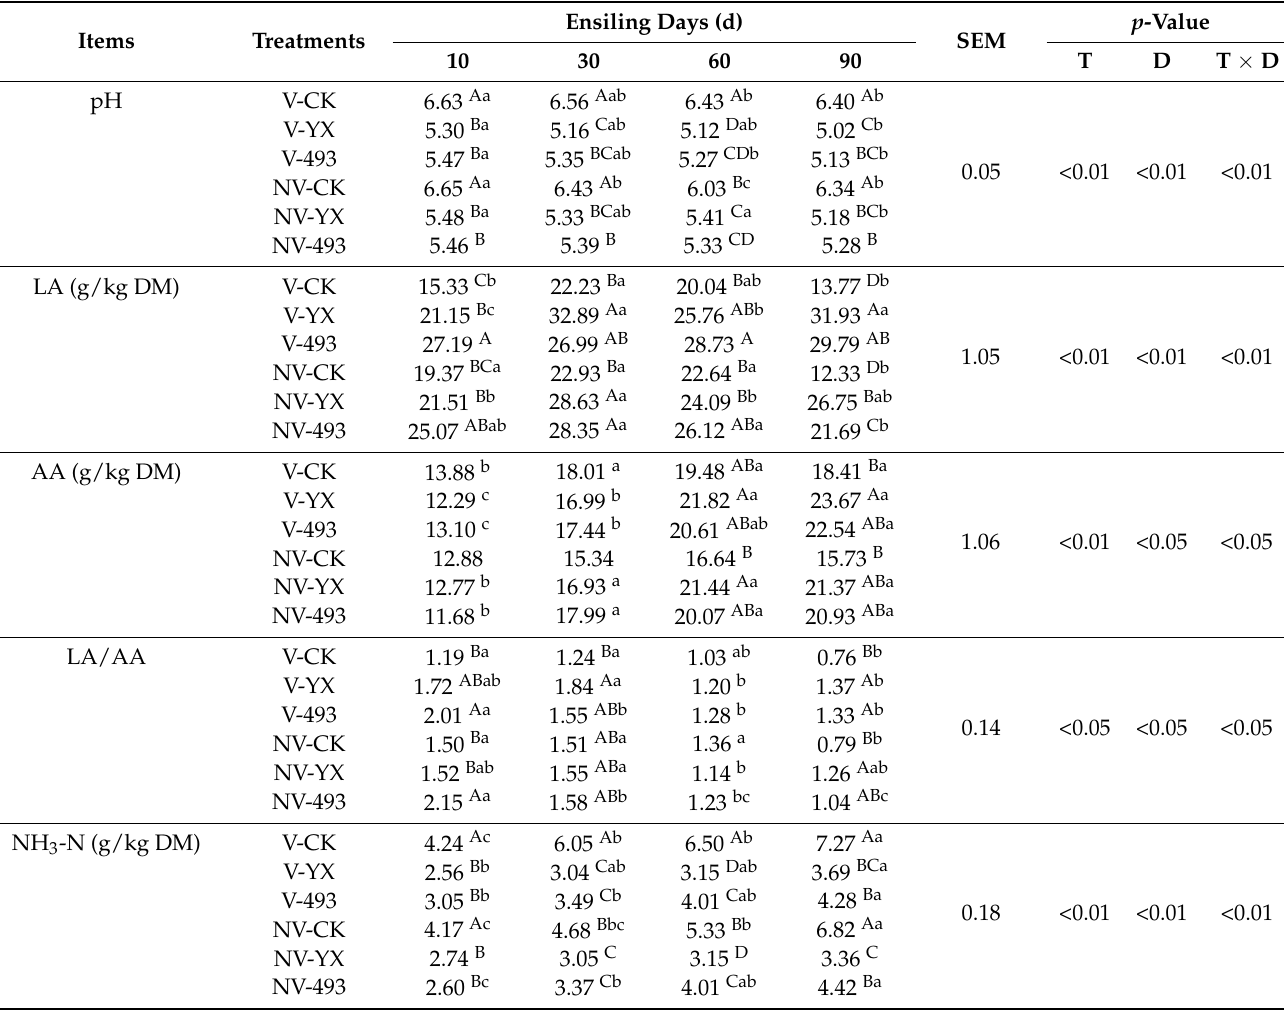
Table 2. Effects of vacuum treatment and inoculants on fermentation characteristics in alfalfa silage at different silage opening